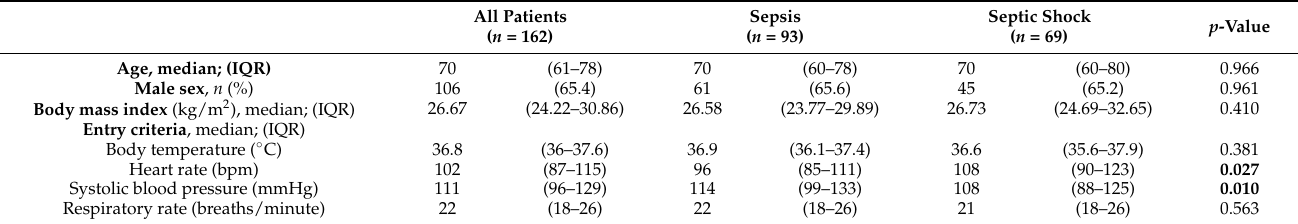
Figure 1. Study population.